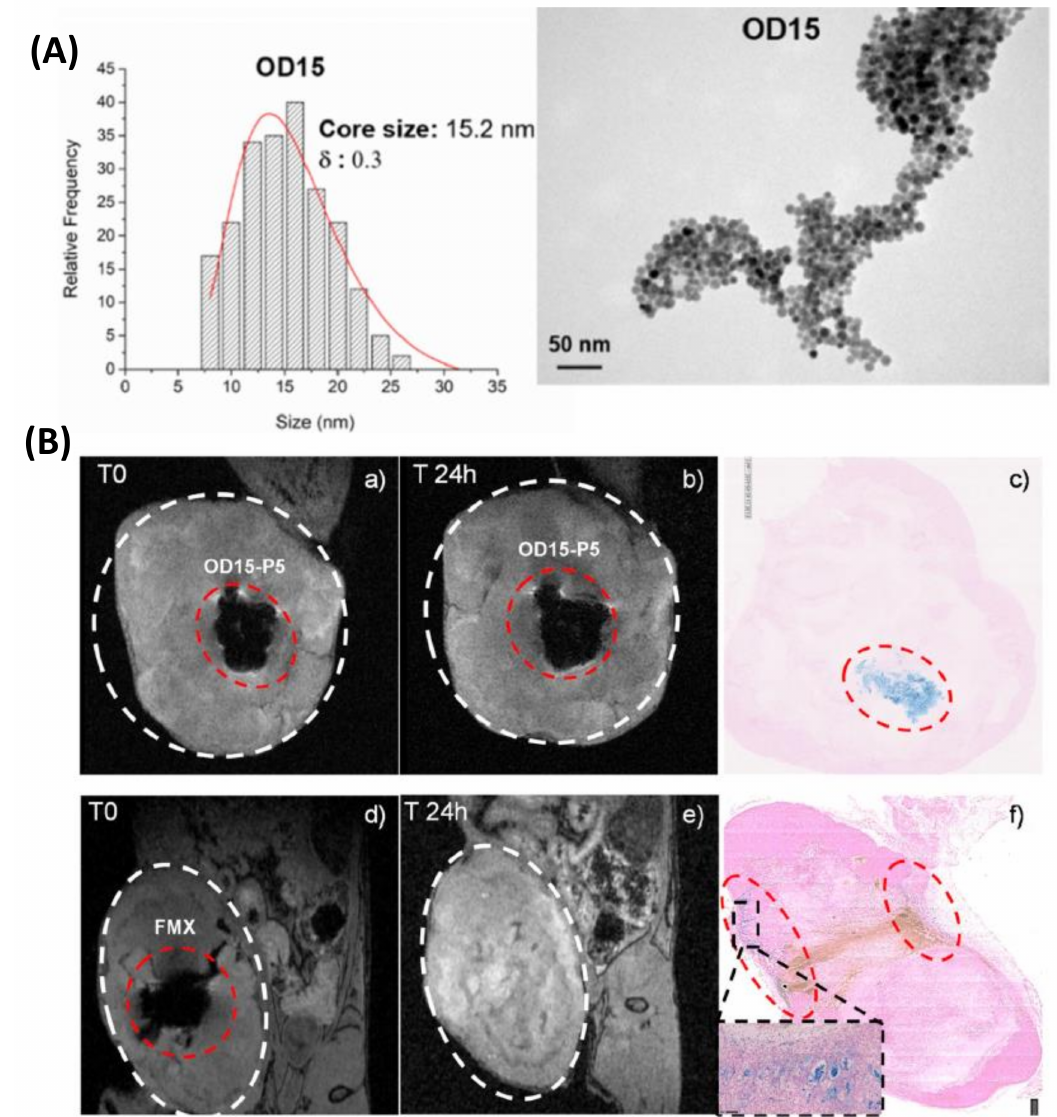
Figure 3. ( A ) Size distribution with log-normal fit (left) and TEM micrograph (right) of OD15 sample. ( B ) Coronal view for T2-weighted gradient-echo 3D MRI of the tumor region in a mouse after the injection of IONPs (( a ), OD15-P5 and ( d ), Ferumoxytol) and 24 h post-injection (( b ), OD15-P5 and ( e ), Ferumoxytol), showing Prussian blue staining of tumor section 24 h post-injection (( c ), OD15-P5 and ( f ), Ferumoxytol). Figure adapted with permission from [61], Copyright 2019 Elsevier